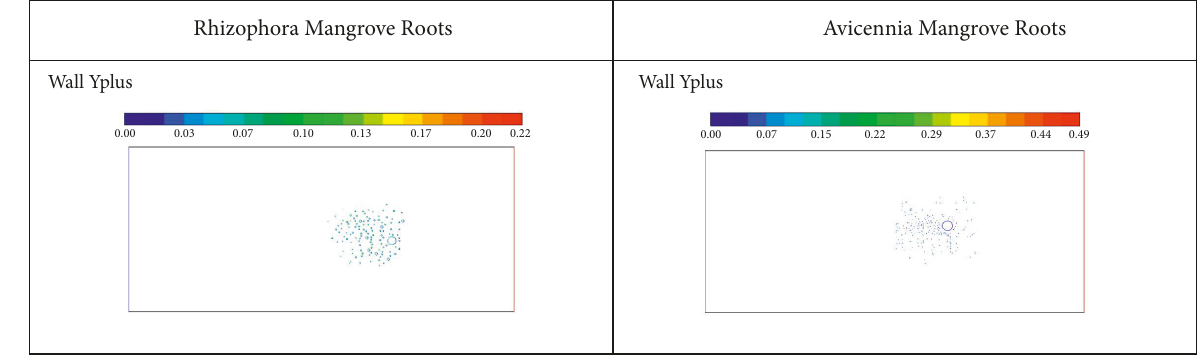
Figure 5: Wall y +: (a) Rhizophora mangrove roots; (b) Avicennia mangrove